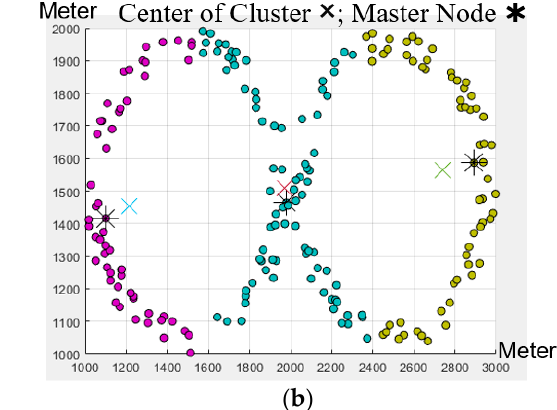
Figure 5. Multi-master cases: ( a ) Two-masters case. ( b ) Three-masters case.